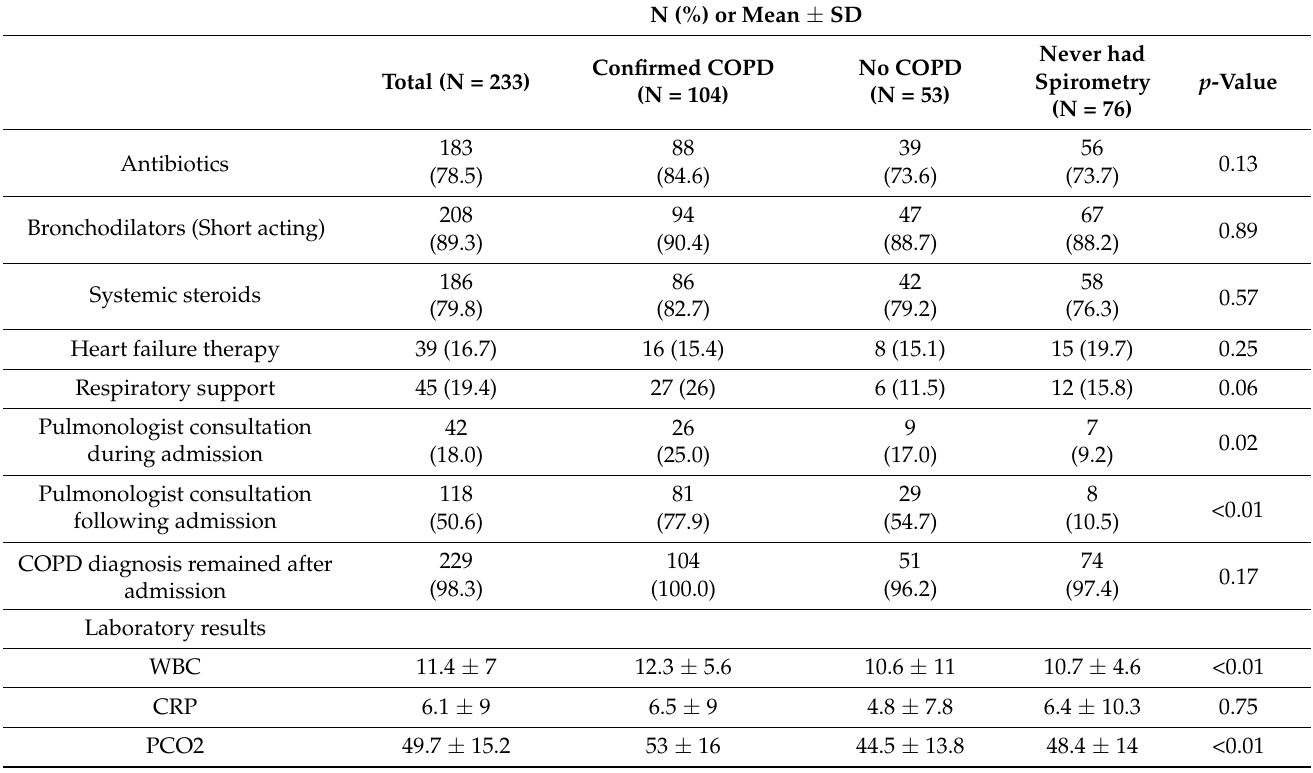
Table 2. Admission course and treatment.